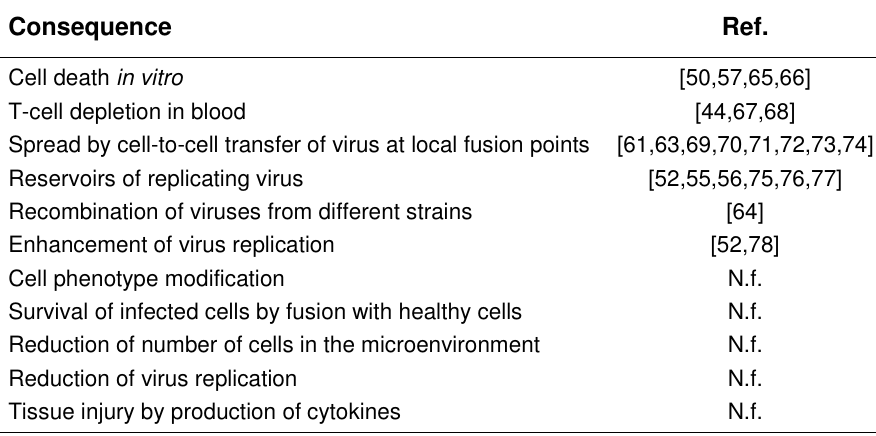
Possible Consequences of HIV-Induced Syncytia Formation Consequence